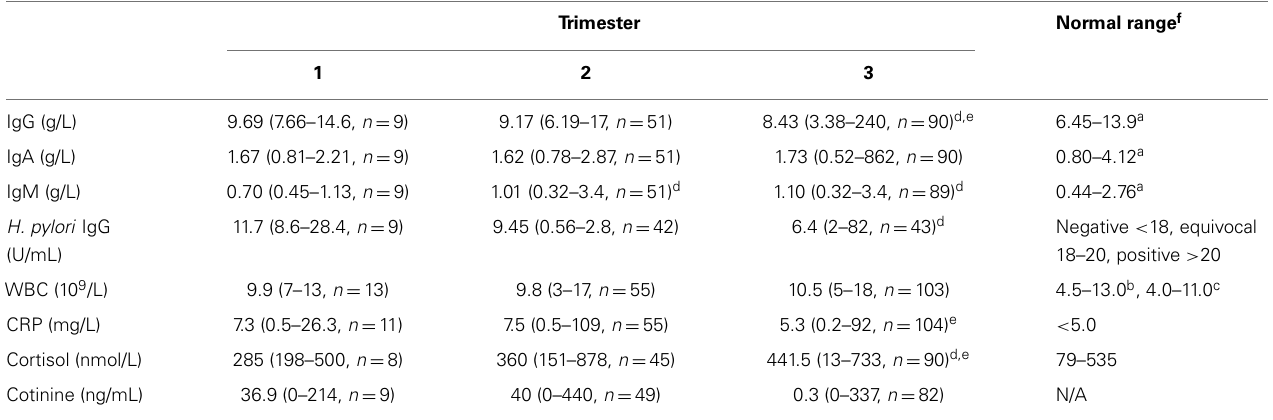
Table 1 | Markers for inflammation and smoking in each trimester of pregnancy in IndigenousAustralian women